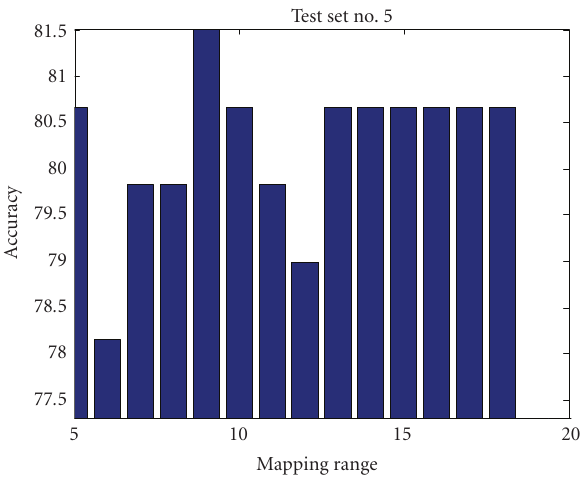
Figure 11: Mapping range impact on algorithm accuracy for test set no. 3.